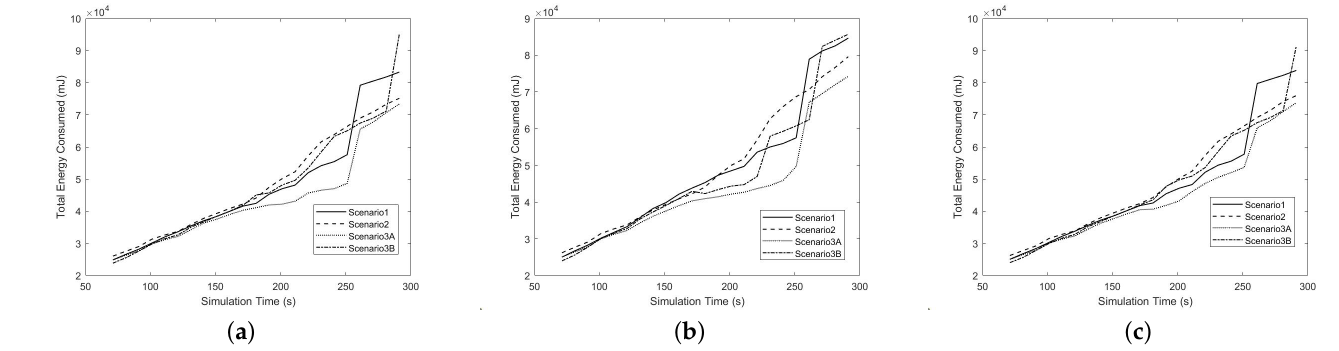
Figure 11. Evaluation of the different Energy Models. ( a ) Energy Model 1, ( b ) Energy Model 2, ( c ) Energy Model